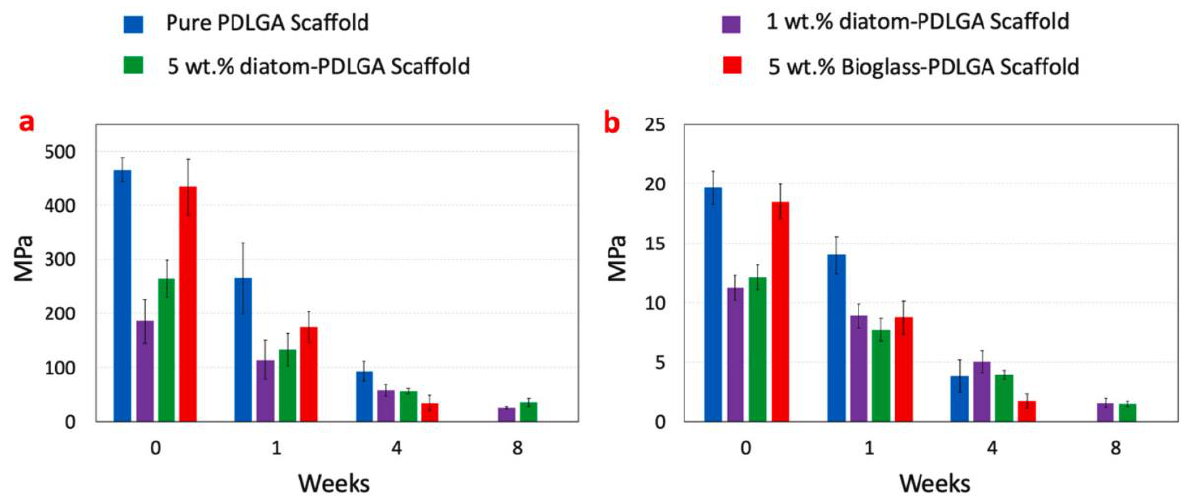
Figure 8. Results from compression test of immersed samples in PBS ( a ) Average Young’s modulus, ( b ) Average yield stress. Reproduced from [146]. Table 4. Principal properties of FDM investigations. With * the compression (not filled cells mean no data).